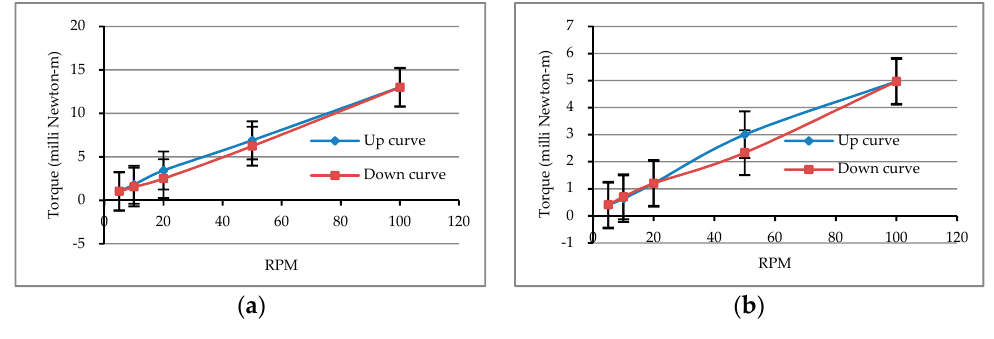
Figure 2. Hysteresis loop of matrixes: ( a ) M9; ( b ) M13.